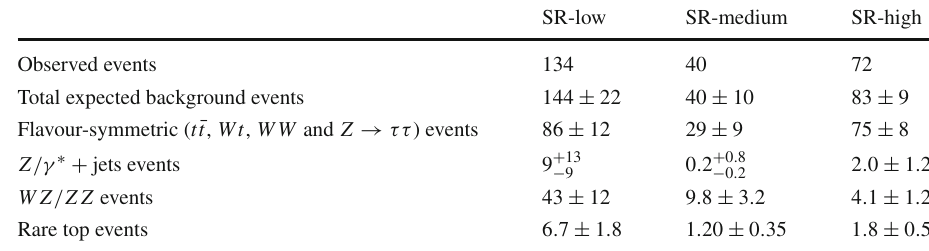
expected and observed data yields for the low- p T signal regions and their corresponding control regions. The quoted uncertainties include the statistical and systematic contributions, and due to anti-correlations with the CRs, the total uncertainty may be less than the sum of individual parts